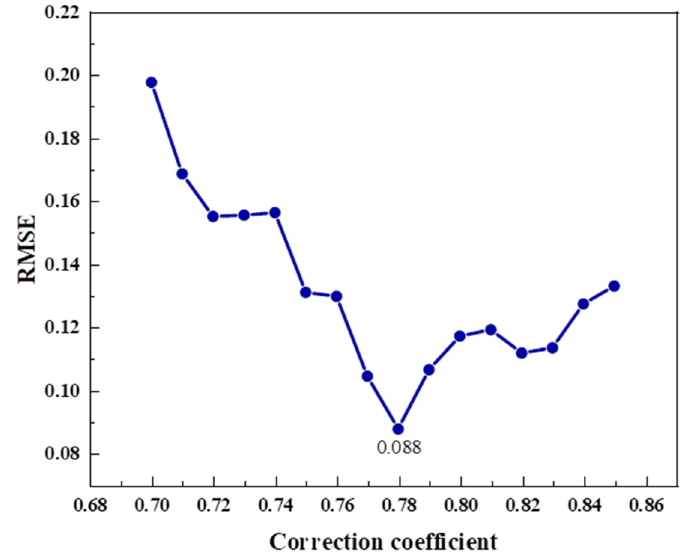
Figure 15. RMSE under different correction coefficients.